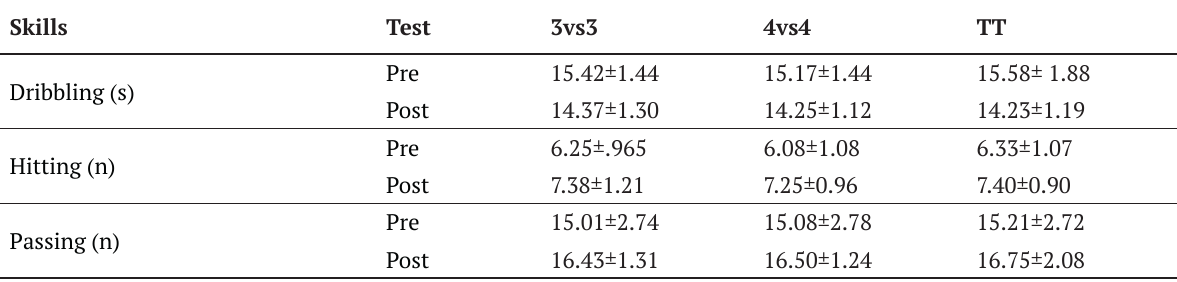
Table 3. Mean and standard deviation for skills performance during pre and post-test between